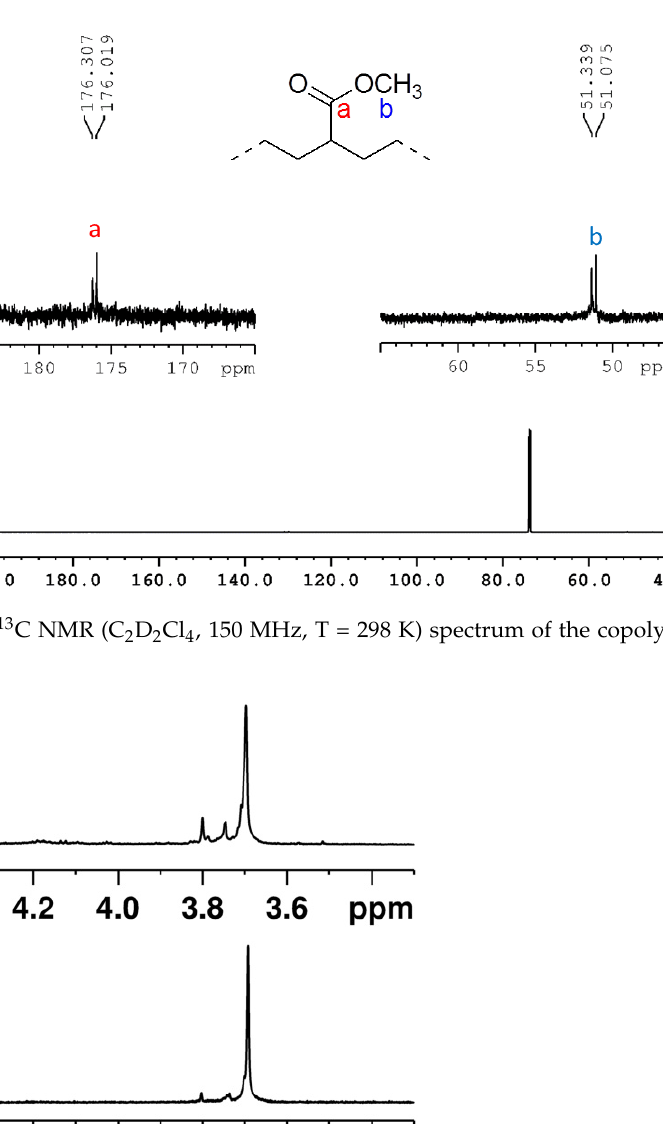
Figure 3. Methoxy region of the 1 H NMR (CDCl 3 , 600 MHz, T = 298 K) spectra of the pen- tane-insoluble ( A ) and pentane-soluble ( B ) fractions of the copolymer sample of run 2, Table 1.